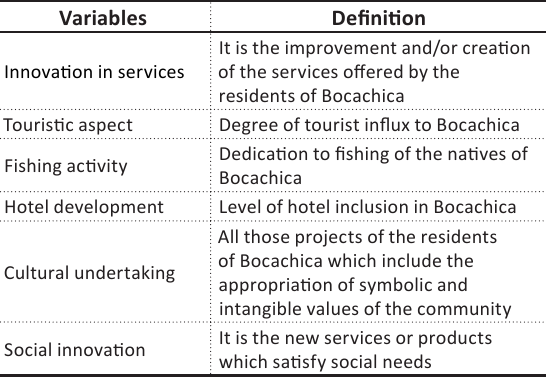
Table 2. Economic dimension